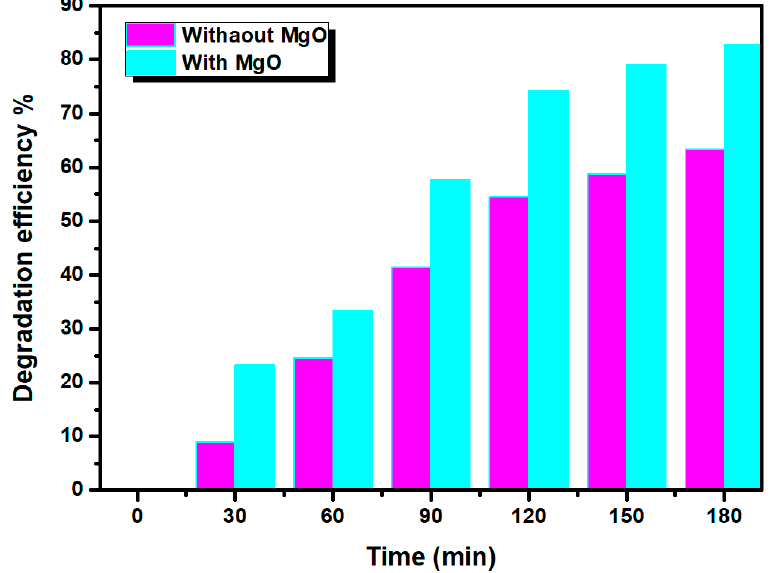
Figure 10. Photodegradation rate variation in MB for two MB solutions: the one contained the optimum MgO (blue) and the other of original solution (pink) for different times.